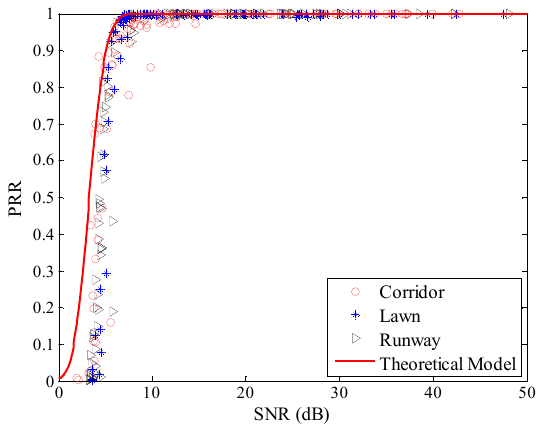
Figure 16. Effects of the theoretical model in different environments. Figure 16. E ff ects of the theoretical model in di ff erent environments. Table 5. RMSEs of SNR based LQEs in di ff erent environments.